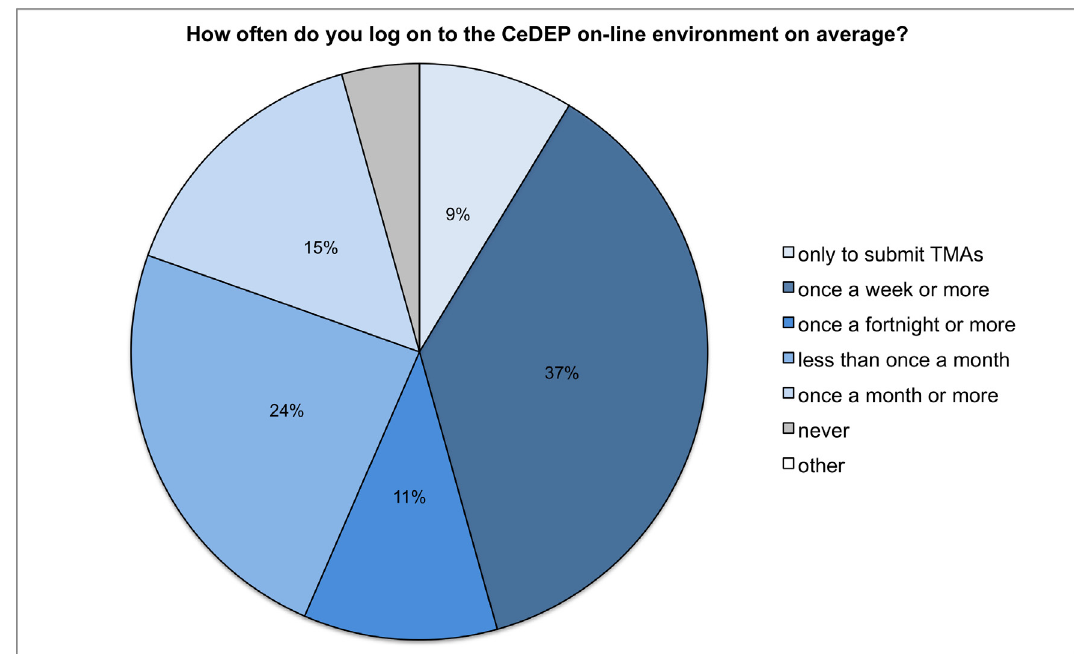
Figure 3 . Student use of the online learning